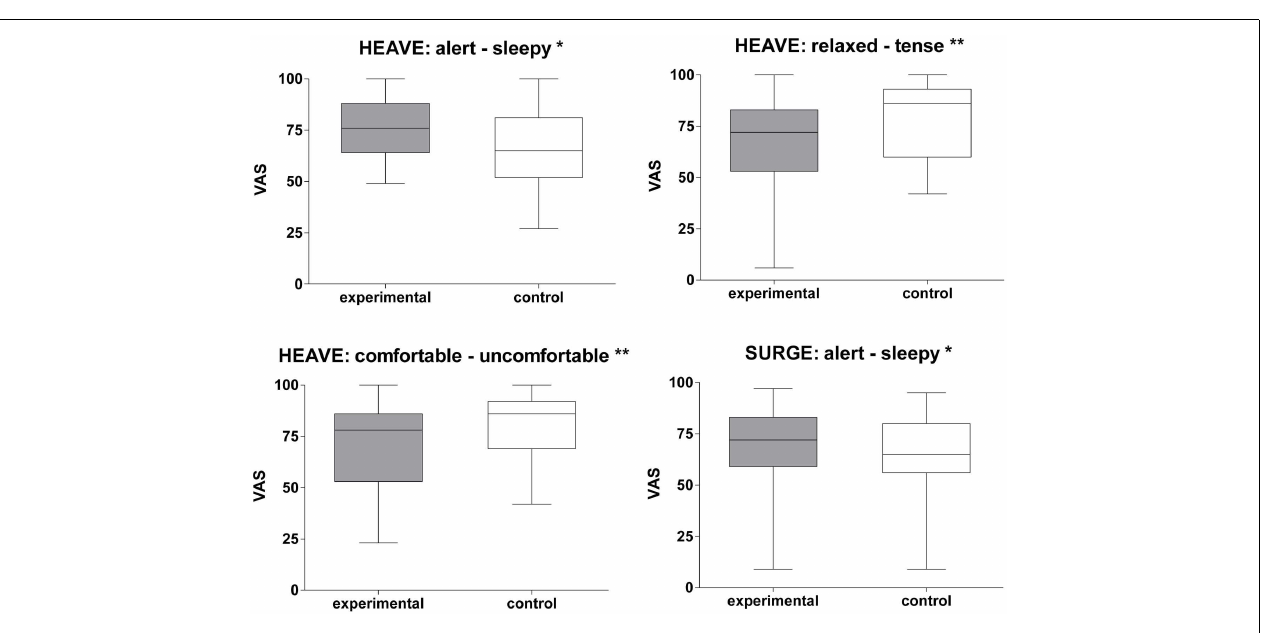
lower quartile, with whiskers showing the minimum and maximum of all values. High values on theVAS indicated that the positive adjective of the pair was appropriate and vice versa for low values. * p < 0.05; ** p < 0.01.